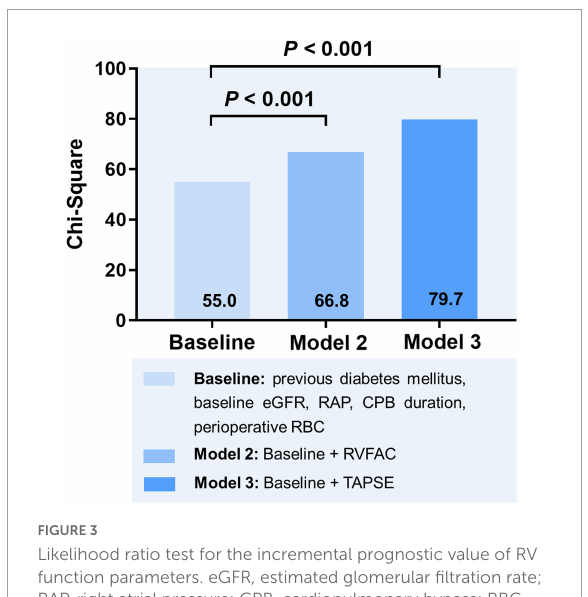
FIGURE3 Likelihood ratio test for the incremental prognostic value of RV function parameters. eGFR, estimated glomerular filtration rate; RAP, right atrial pressure; CPB, cardiopulmonary bypass; RBC, red blood cell; RVFAC, right ventricular fractional area change; TAPSE, tricuspid annular plane systolic